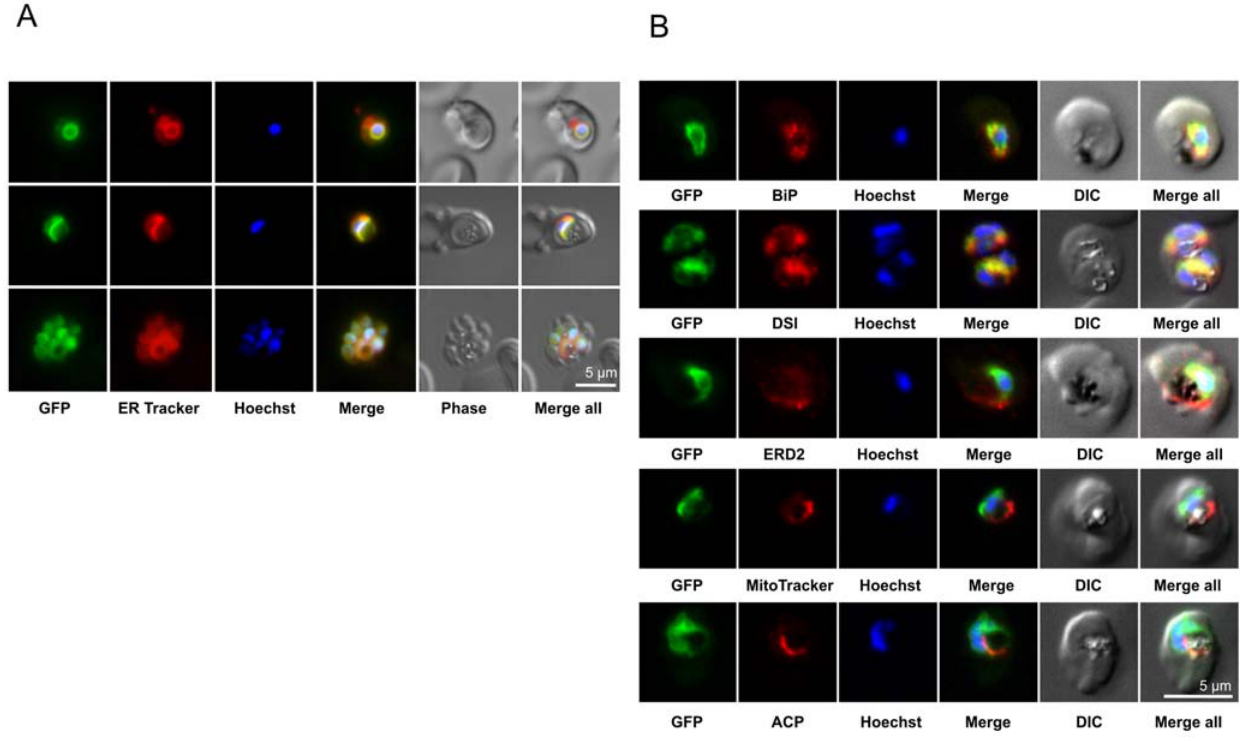
Figure 5. Localization of PfSCD-GFP in the parasite endoplasmic reticulum. (A) Direct fluorescence assays of PfSCD-GFP-expressing P. falciparum parasites (strain Dd2 attB :: Pfscd-gfp ) with GFP (green), ER Tracker (red), and nuclear staining with Hoechst 33342 (blue). Images represent various stages of the erythrocytic cycle, respectively from top to bottom: early trophozoite, late trophozoite and segmented schizont. (B) Colocalization studies. PfSCD-GFP was colocalized with different compartment markers: ER (PfBip, PfDSI), cis -Golgi (PfERD2), mitochondria (MitoTracker Red), and apicoplast (PfACP).